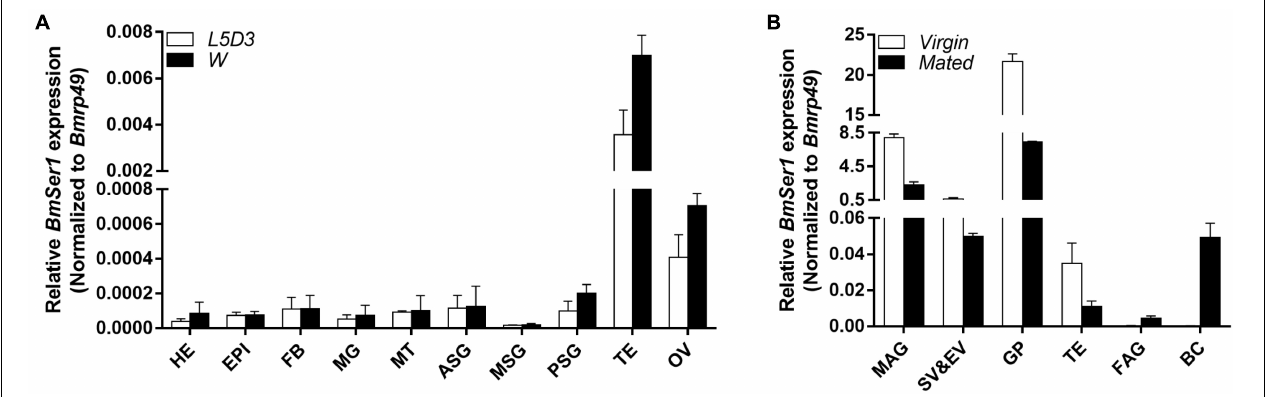
FIGURE 2 | Spatial and temporal expression of BmSer1 in WT individuals. (A) BmSer1 expression in ten tissues at L5D3 and W stages. (B) BmSer1 expression in six tissues at virgin and mated adult stages. Abbreviations: epidermis (EPI), fat body (FB), midgut (MG), Malpighian tubules (MT), anterior silk gland (ASG), middle silk gland (MSG), posterior silk gland (PSG), testis (TE), ovary (OV), male accessory gland (MAG), seminal vesicle and ejaculatory vesicle (SV&EV), glandula prostatica (GP), female accessory gland (FAG), and bursa copulatrix (BC). mRNA expression was normalized to Bmrp49 . The data shown are means ± S.E.M.